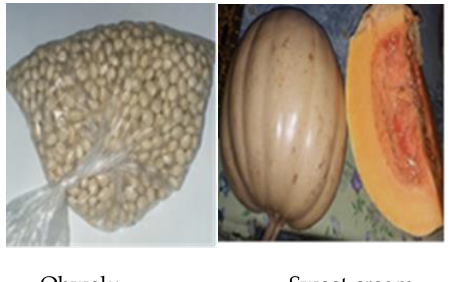
Figure 1. Common bean, Obwelu and pumpkin, Sweet cream used in the preparation of the complementary foods (CFs).